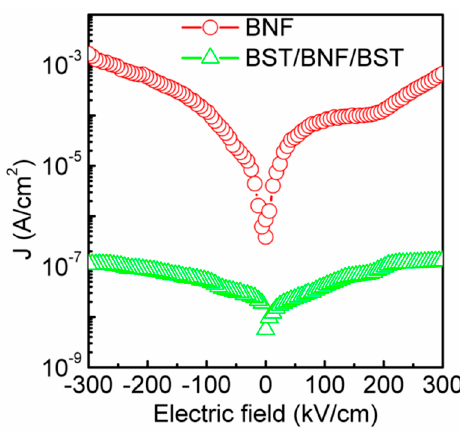
Figure 5. J – E characteristics of BNF and BST/BNF/BST films on Pt(111)/Ti/SiO 2 /Si(100) substrate measured at room temperature.